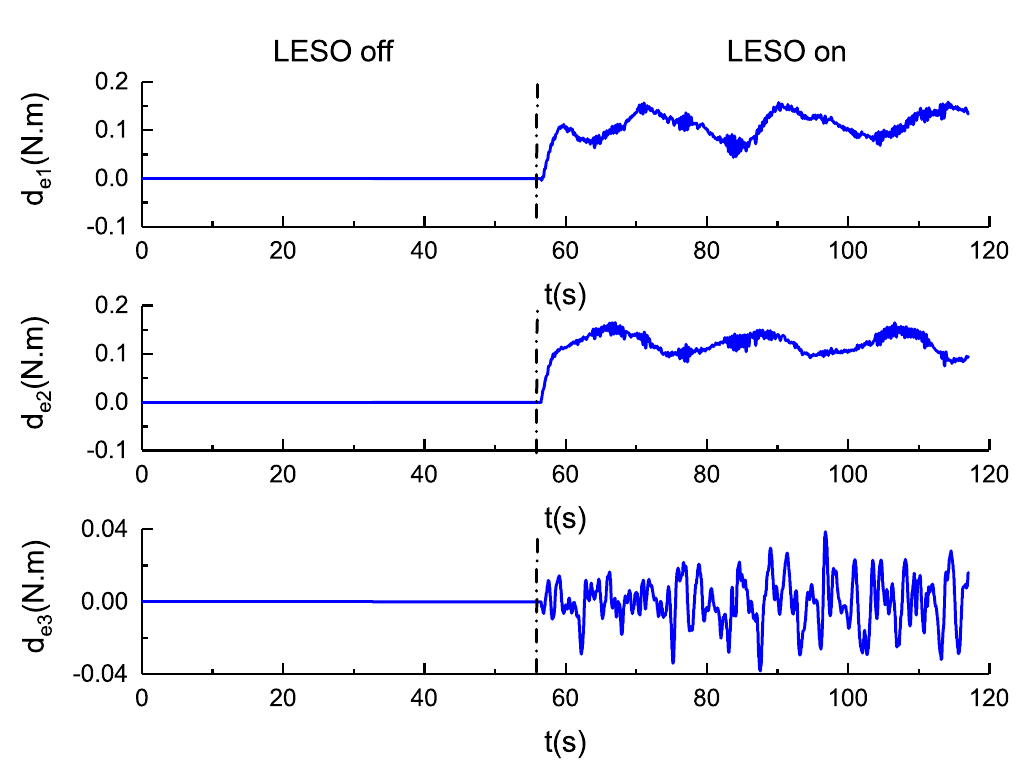
Figure 10. Disturbance estimation with the LESO on using attitude